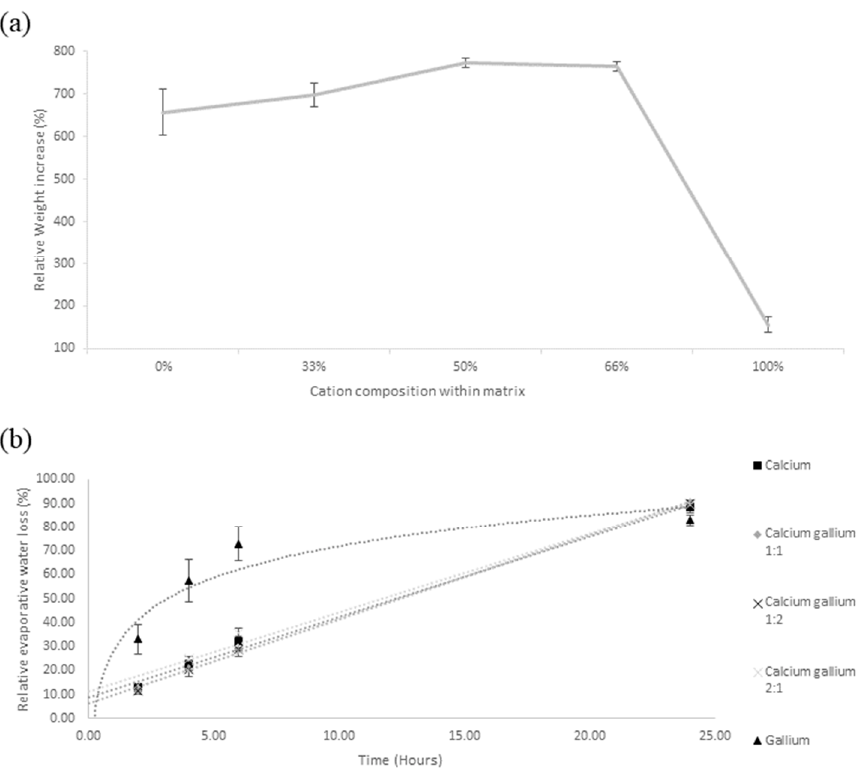
Figure 7. ( a ) Average swelling capacity with respect to the changes in cation composition. ( b ) Average change in evaporative water loss for calcium alginate, gallium alginate, calcium gallium alginate 1:1, calcium gallium alginate 1:2 and calcium gallium alginate 2:1.